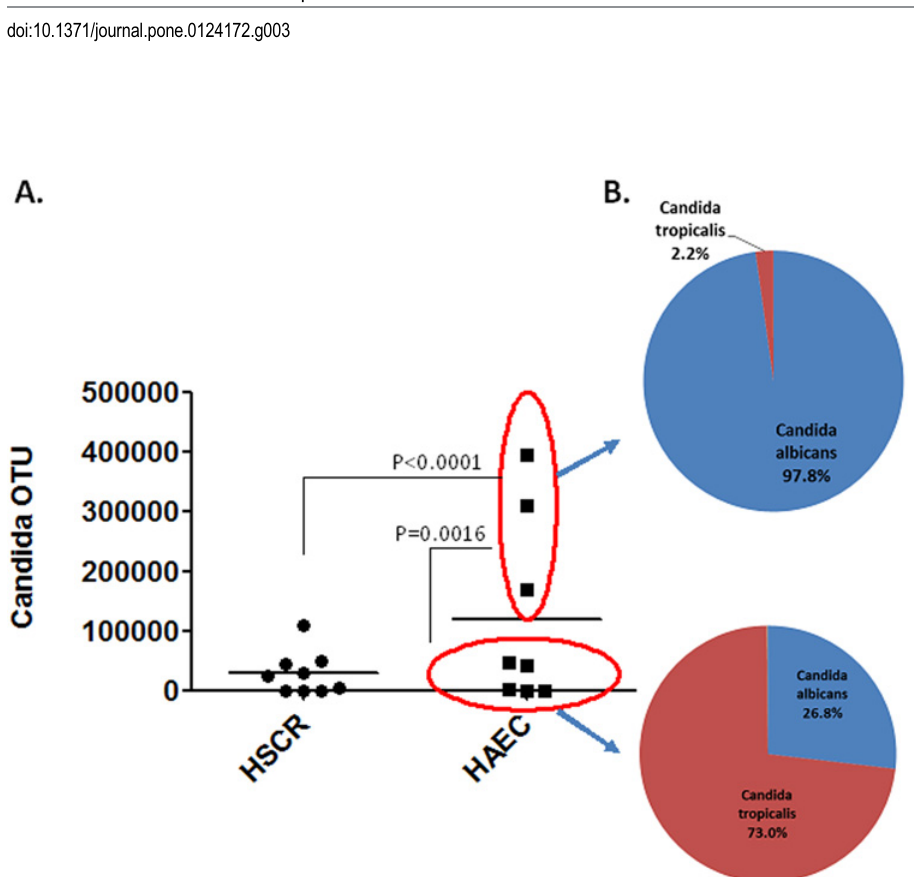
Fig 4. Candida albicans and tropicalis OTU abundance by phenotype. A, The OTU abundance of Candida in feces of HSCR and HAEC patients. Three out of eight HAEC patients showed very elevated Candida OTU ’ s. B, relative distribution of C . albicans to C . tropicalis in the “ high burden ” patients compared with the “ low burden ” patients. Comparisons between each group using t -test are noted. There was no significant difference between the HSCR and HAEC- Candida low burden groups.